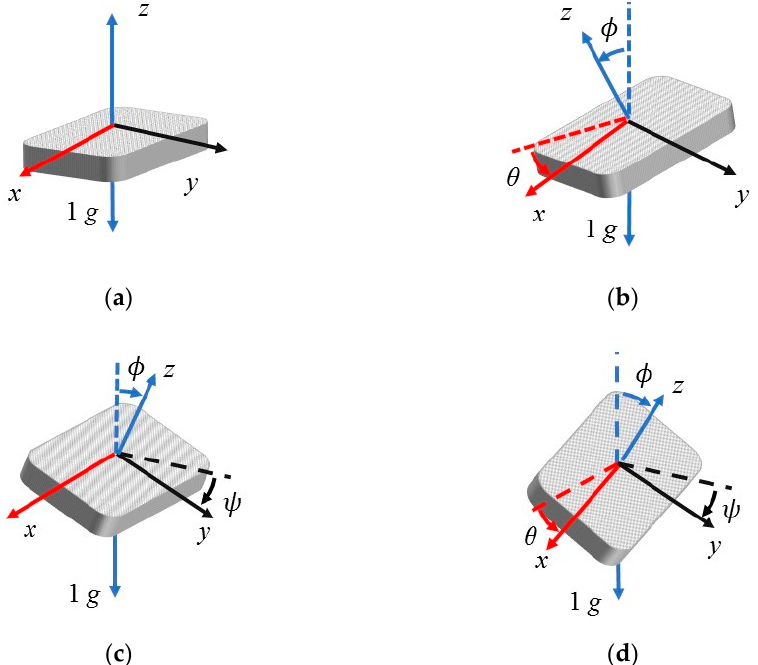
Figure 1. Sensing angles of the MEMS inclinometer. ( a ) The typical reference position; ( b ) an illustration of angles 𝜙 and 𝜃 and the relationship between them; ( c ) an illustration of angles 𝜓 and 𝜙 and the relationship between them; ( d ) three sensing angles of the MEMS inclinometer.